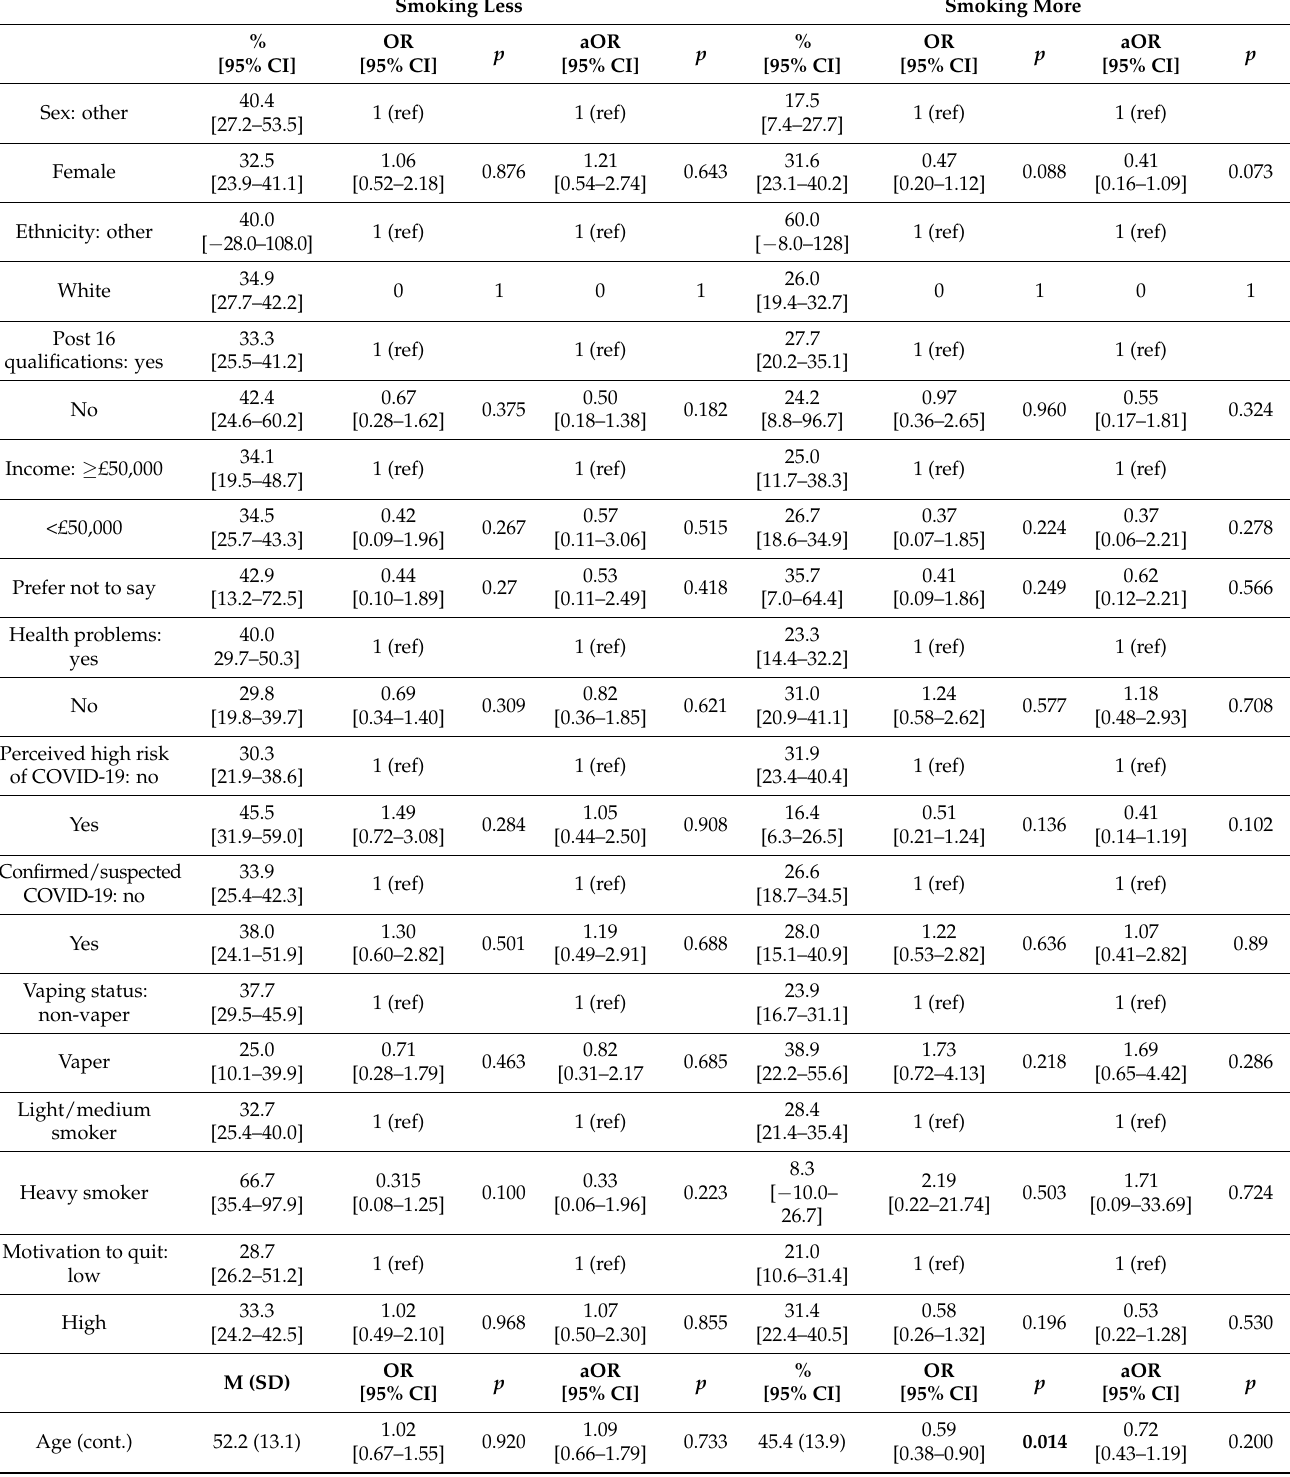
Table 3. Correlates of smoking less and smoking more numbers of cigarettes per day between baseline and the 12-month follow-up among current smokers at both time points (N =